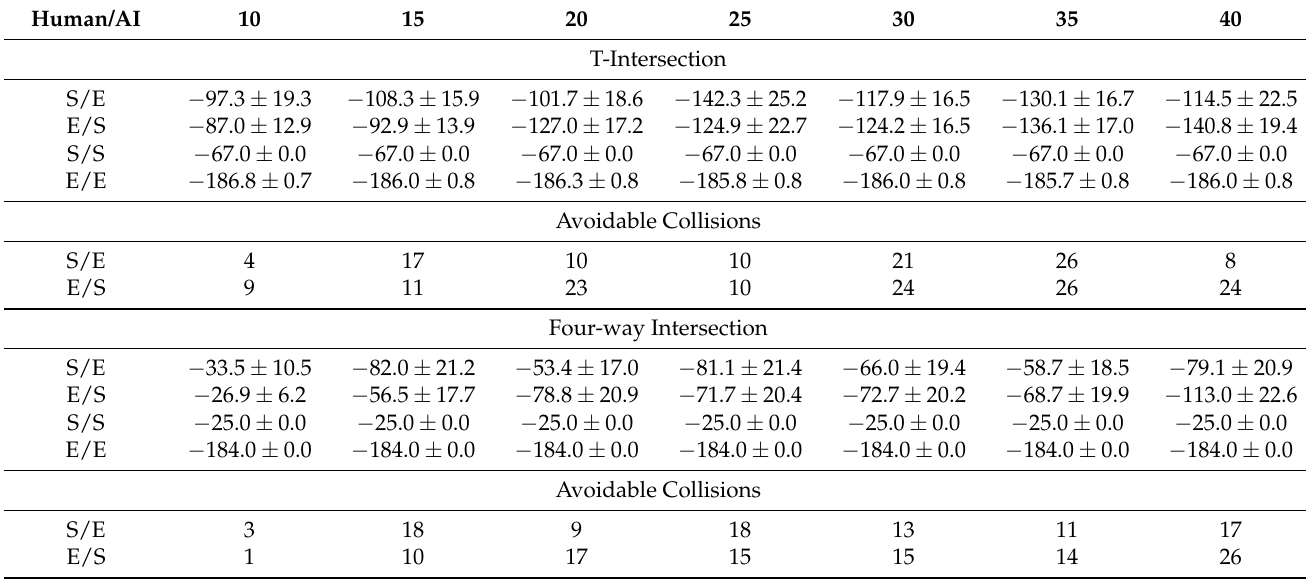
Table 16. Mean rewards and avoidable collision counts (by human–AI configuration) for a random manager with given delegation interval lengths in the human: sensor and mask, AI: sensor and mask